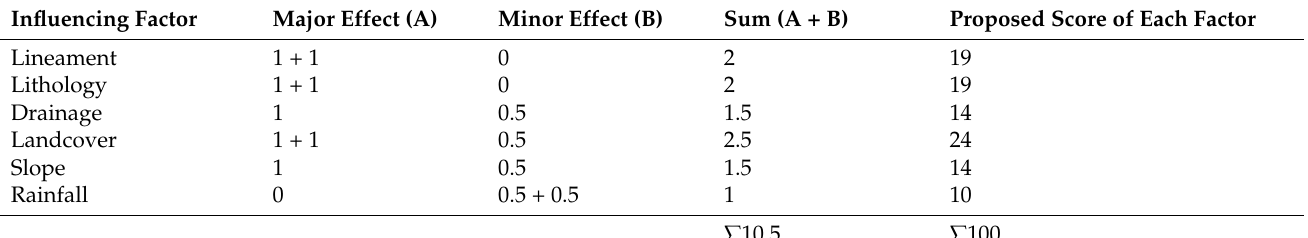
Table 2. Reclassified values of the influencing factors on the recharge potentiality.